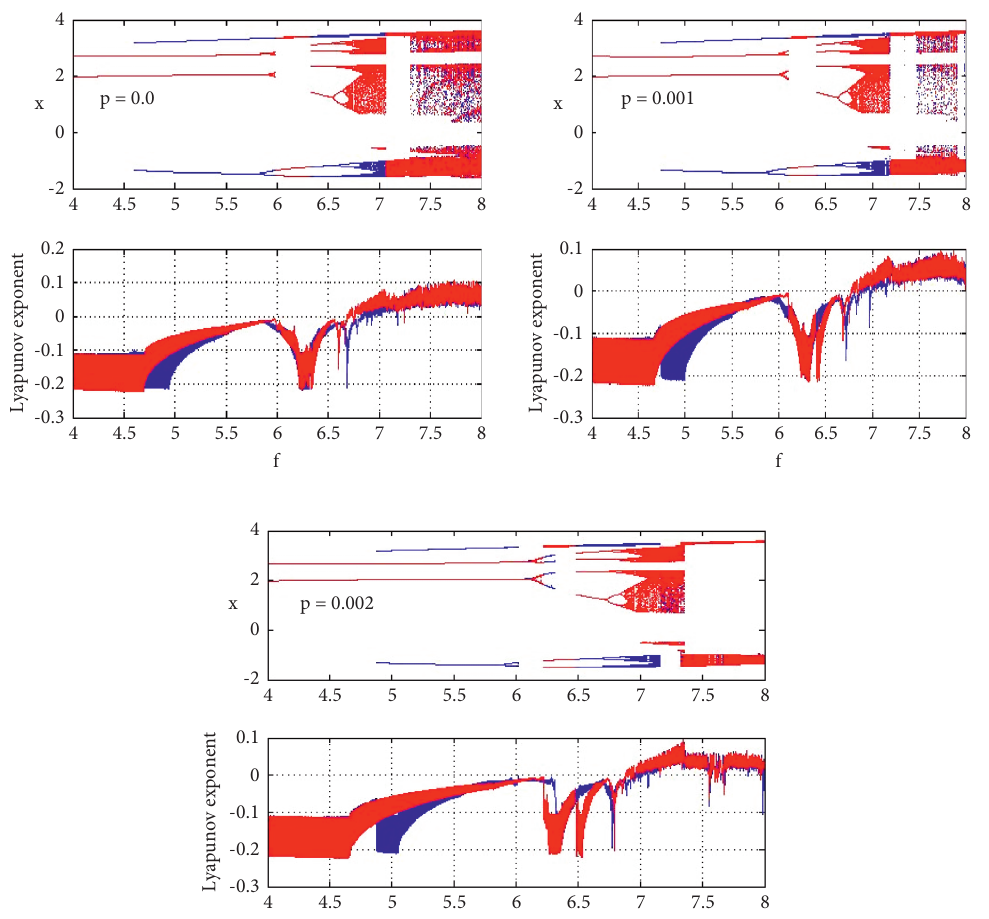
Figure 5: Bifurcation diagrams and its corresponding Lyapunov exponents vs. f exhibiting the effect of p with the parameters of Figure